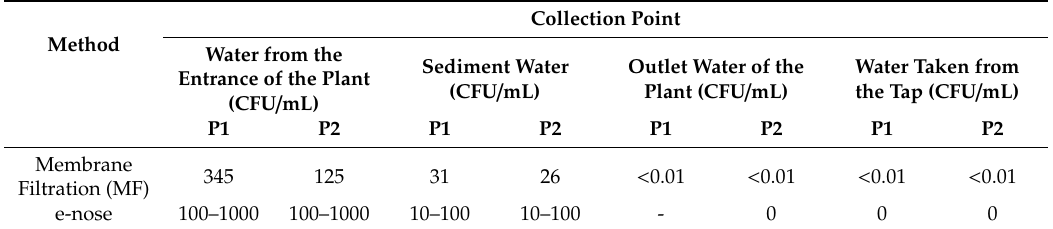
Table 5. Comparison of the results obtained by the two